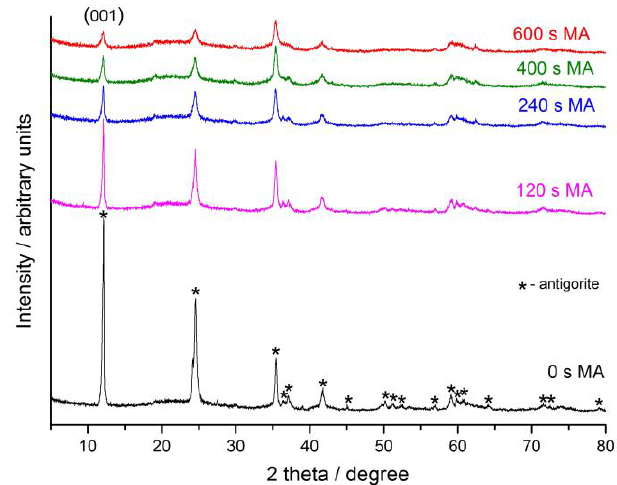
Figure 2. The X-ray diffraction patterns of initial antigorite (0 s MA) and antigorite that had been milled in air in moderate conditions.